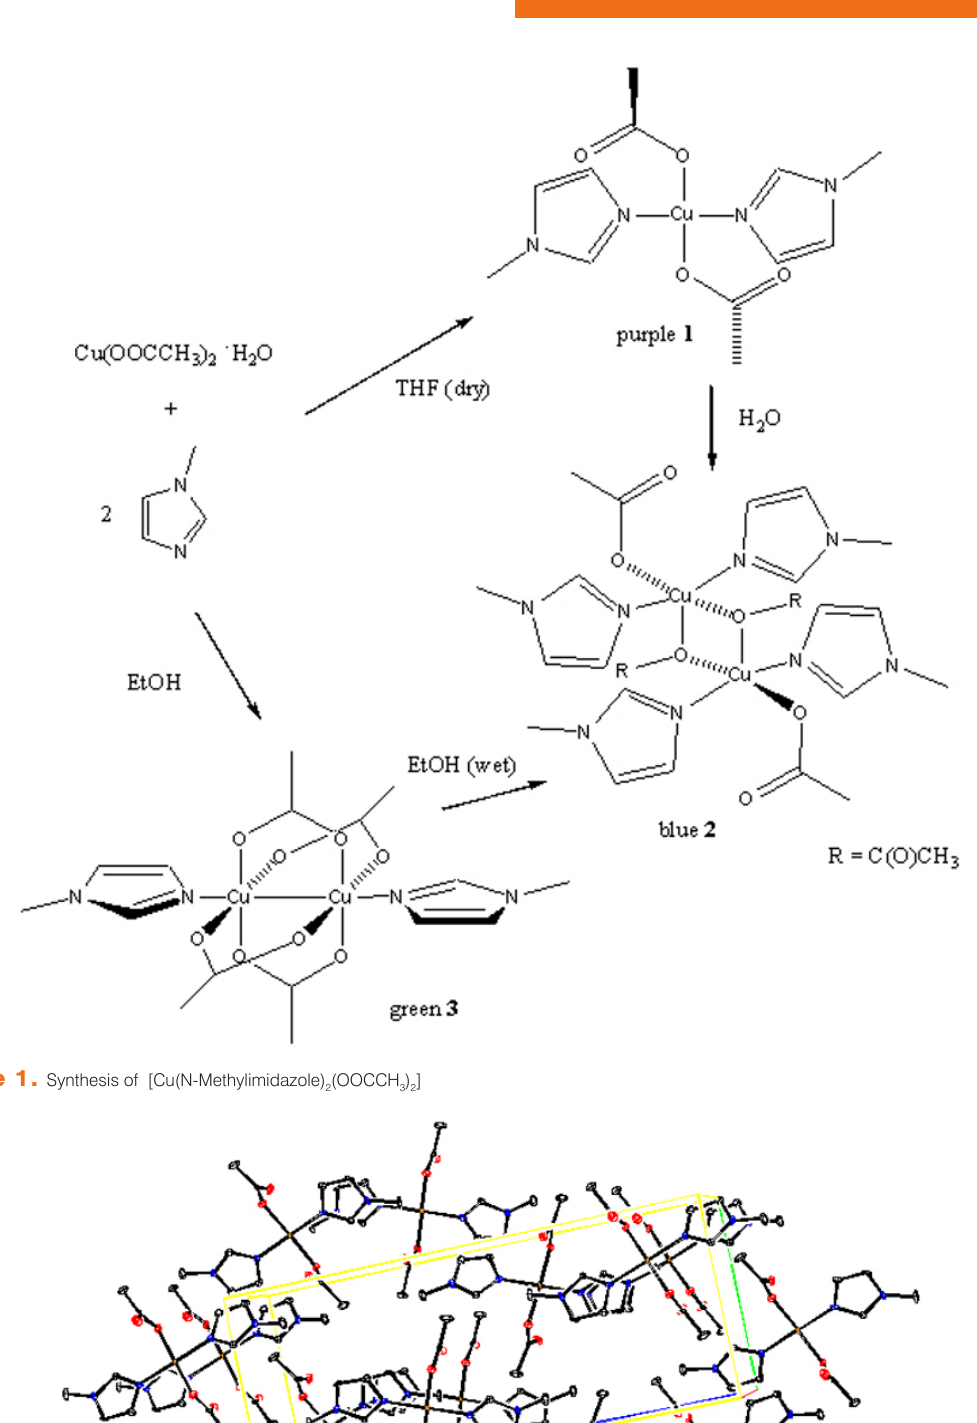
Figure 2. ORTEP plot (50% probability) of the crystal packing of purple [Cu(N-Methylimidazole)